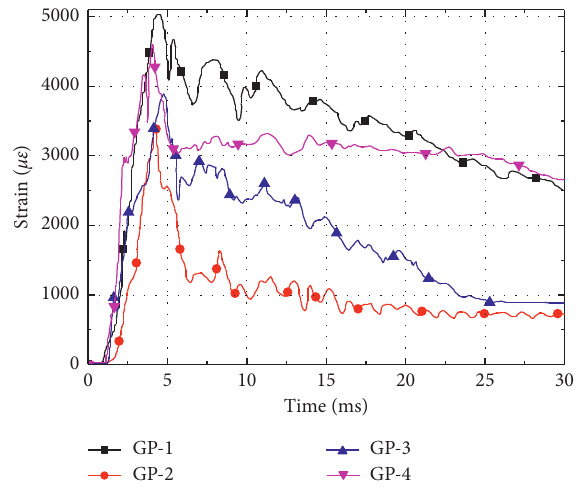
Figure 16: Strain time-history curves of ST2 collection